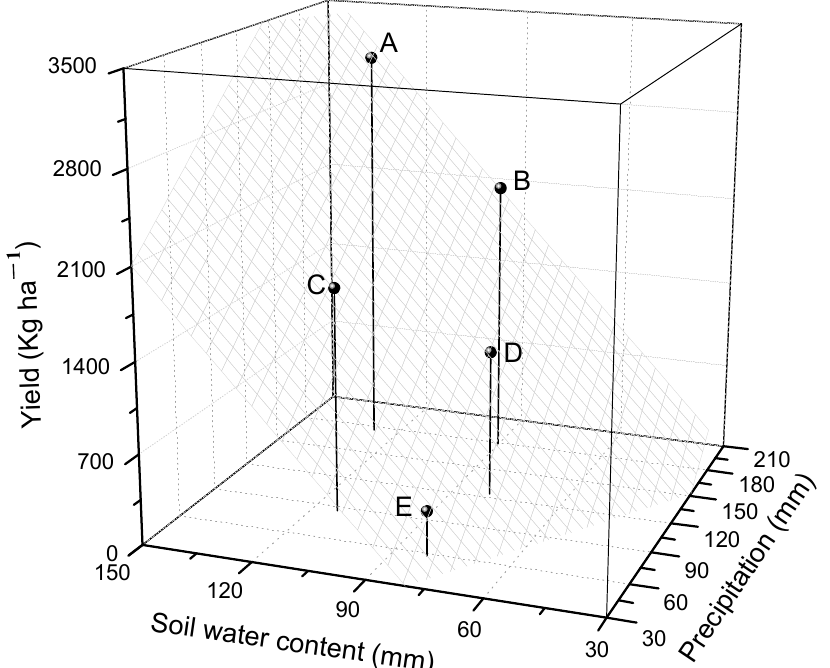
Figure 5. Spring wheat yield as determined by soil water content at planting and precipitation during spring wheat growing season at Dingxi, Gansu Province, China. The ANOVA analysis of spring wheat yield, soil water content at planting, and growing season precipitation for different climatic patterns is shown in Table S2.